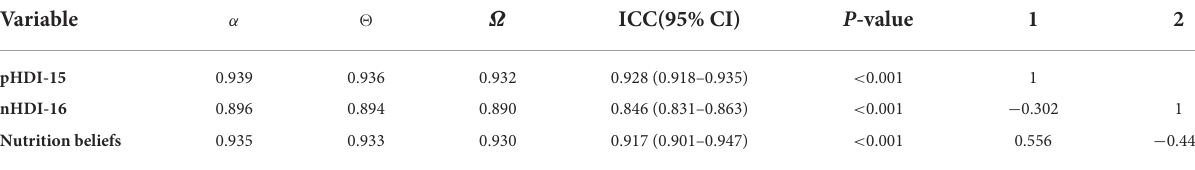
TABLE 3 Correlation and reliability (internal consistency and test-retest) of two scales of food frequency consumption and nutrition beliefs. Variable